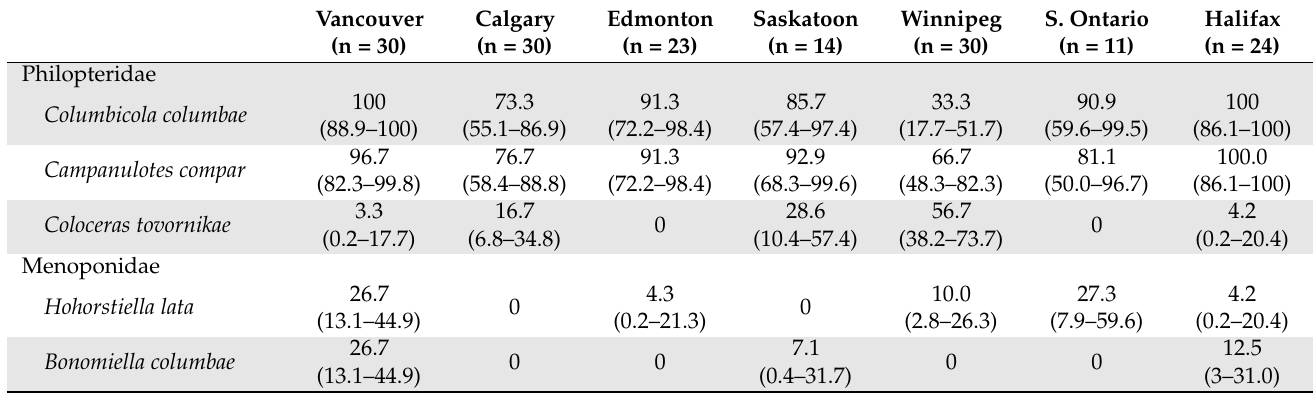
Figure 3. Prevalence of the non-feather dwelling mites: ( A ) Ornithocheyletia hallae , ( B ) Harpyrhynchoides gallowayi , ( C ) Harpyrhynchoides columbae , ( D ) Tinaminyssus melloi , and ( E ) Tinaminyssus columbae infesting Columba livia sampled from seven locations across Canada, 95% confidence intervals. Sample sizes refer to number of C. livia examined from each location. Table 2. Prevalence of lice found on Columba livia collected from seven locations across Canada. 95% confidence intervals in